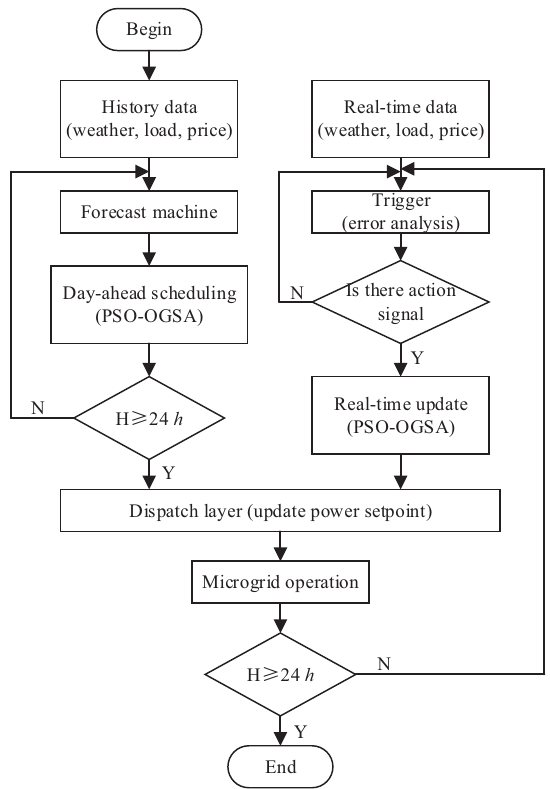
Figure 3. Simple flow chart of the proposed TSD model for a MOOD